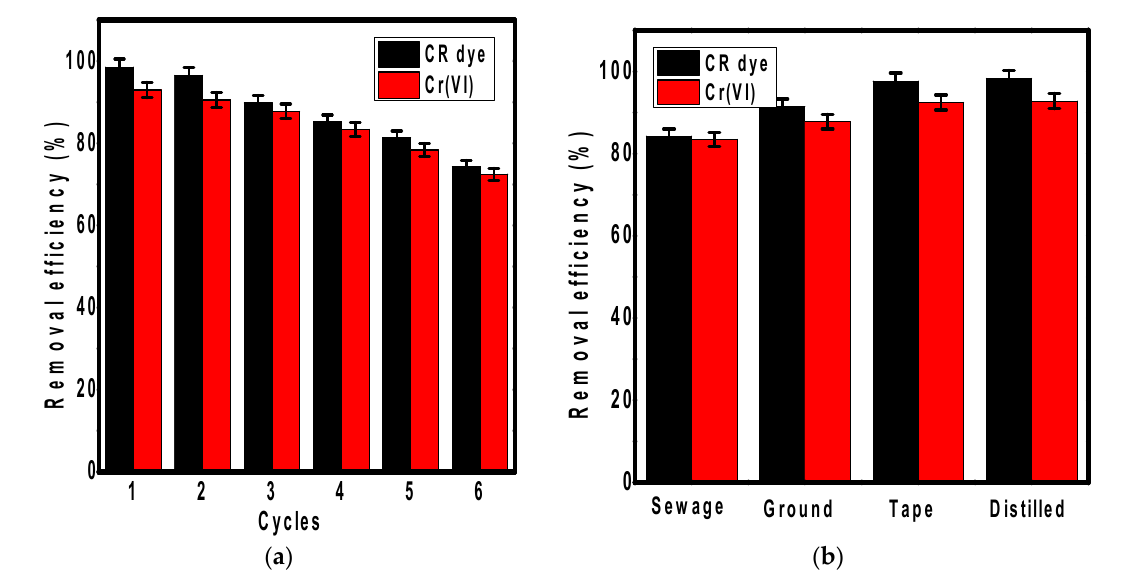
Figure 5. The regeneration study of PPy/Fe 3 O 4 /SiO 2 nanocomposite for the removal of Congo red dye and Cr(VI) up to six successive cycles ( a ) and the effect of water type ( b ).